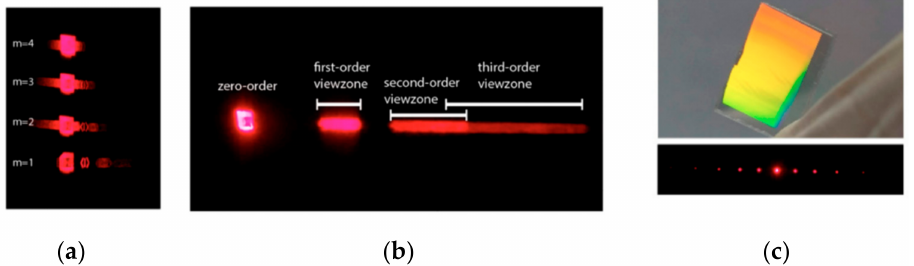
Figure 12. ( a ) Multi-order outputs for a fixed grating SAW simulation. ( b ) viewzones for a multi- order output. ( c ) Diffracted orders from a laser-induced grating in the bulk of lithium niobate. Reprinted with permission from [52].